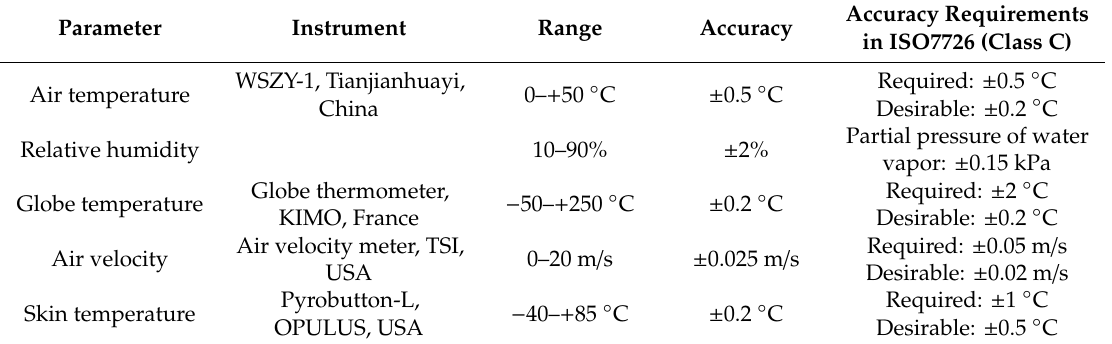
Table 4. Instrument